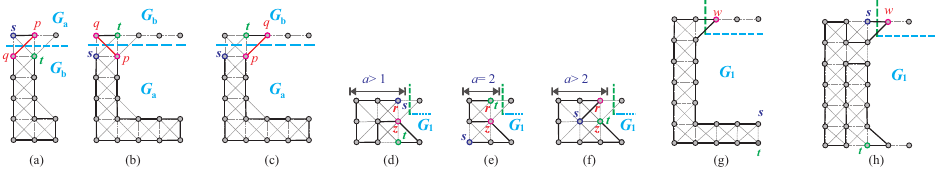
Figure 26. The longest ( s , t ) -path under that a (cid:62) 2 and c = 1, where ( a – c ) (UB10) holds, ( d – f ) (UB11) holds, and ( g , h ) (UB12)